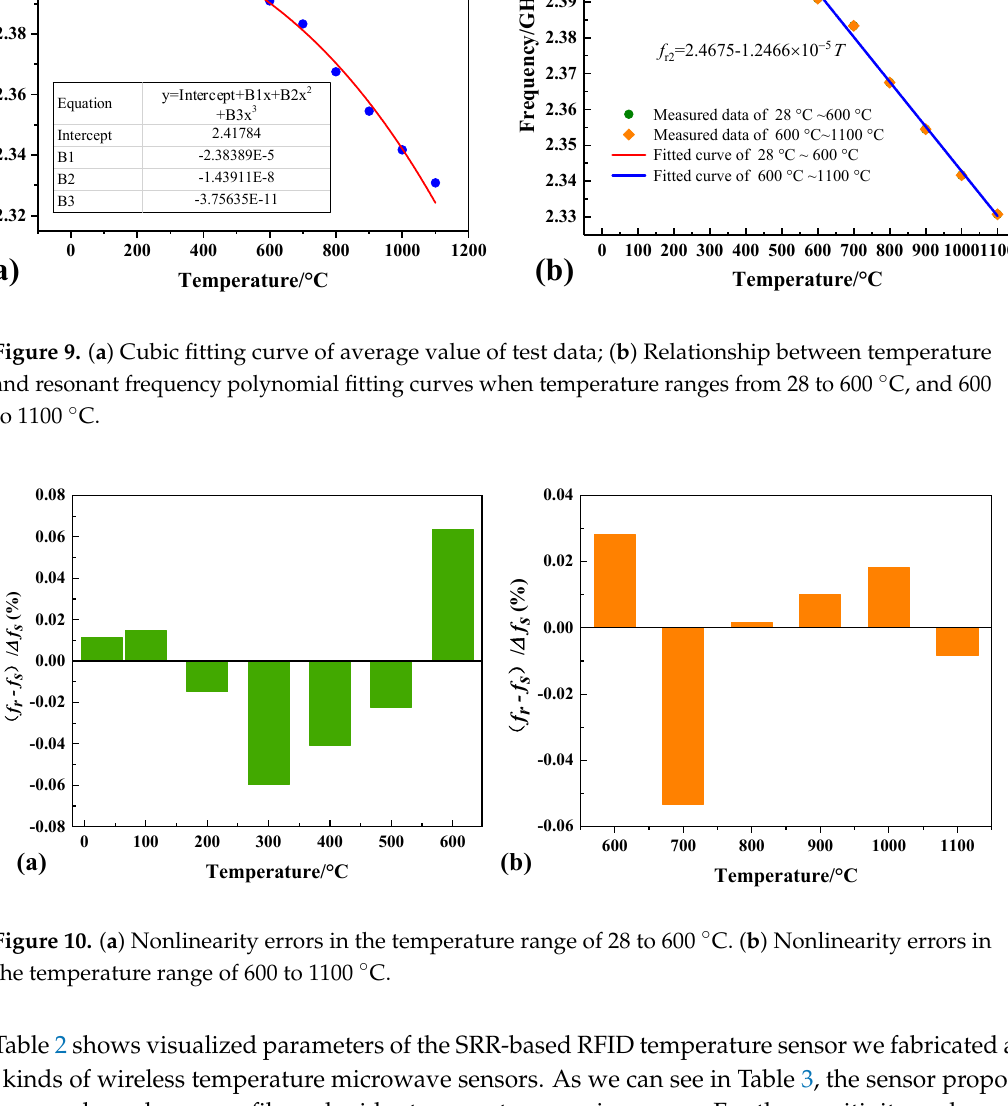
◦ C. ( b ) Nonlinearity errors in